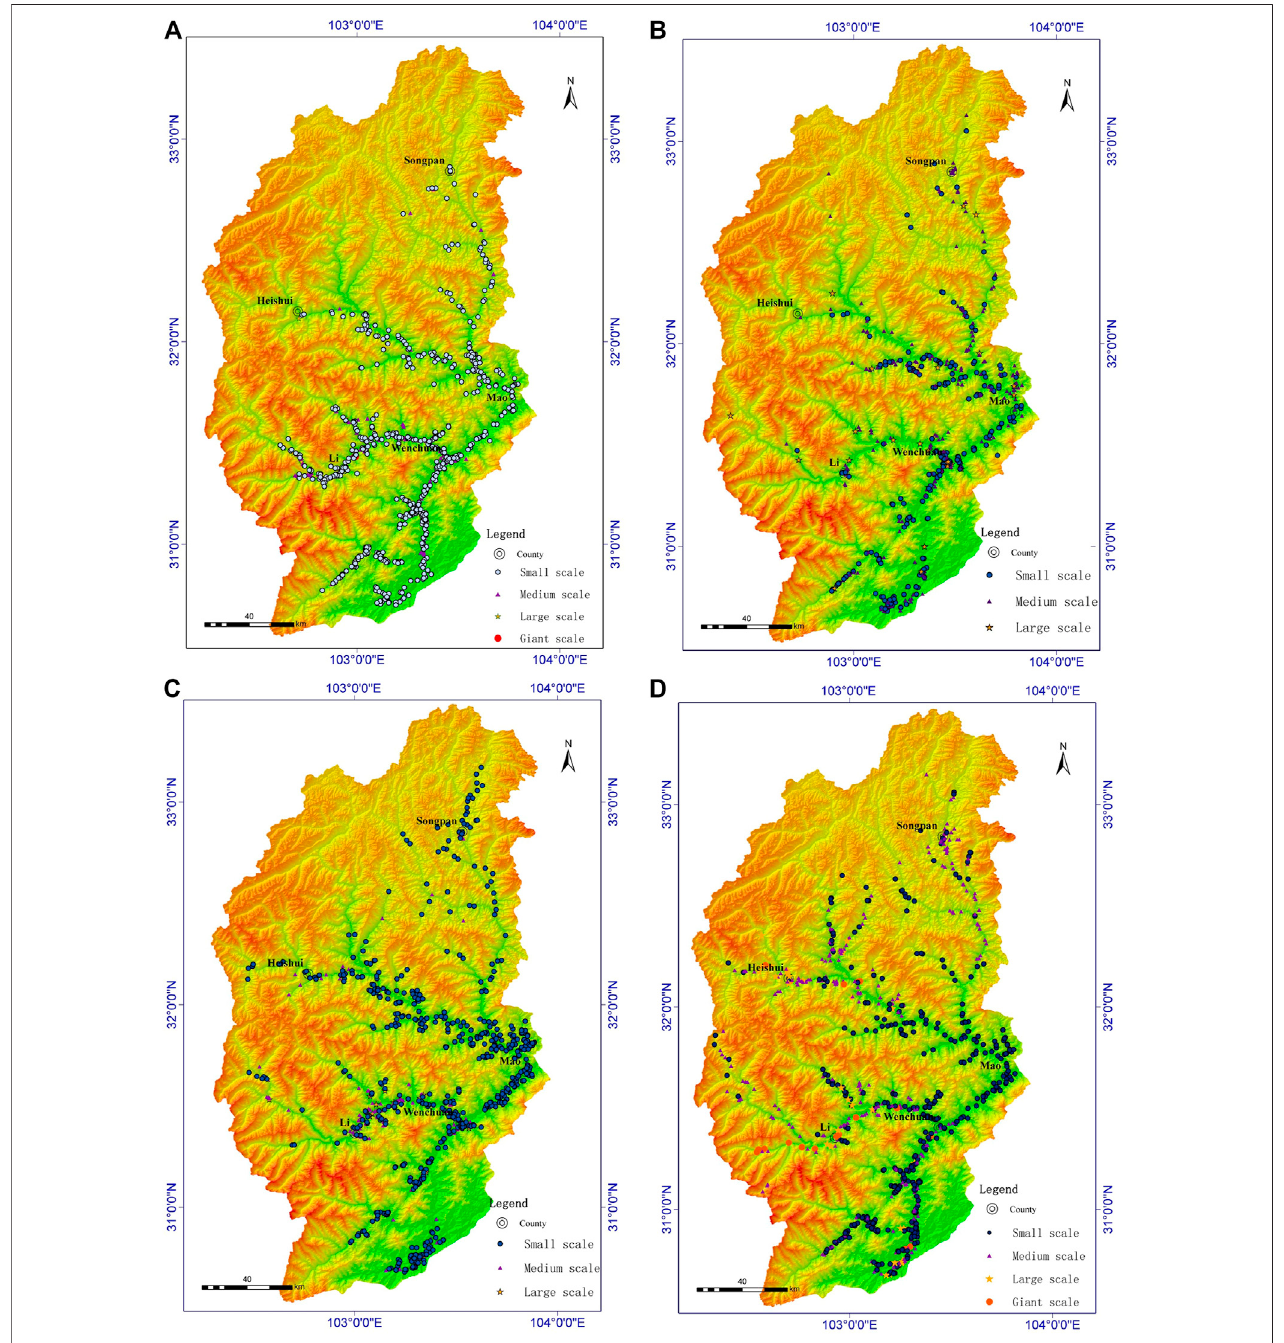
FIGURE 3 | The distribution of collapses (A) , unstable slopes (B) , landslides (C) , and debris fl ows (D) in the upper reaches of the Min River.